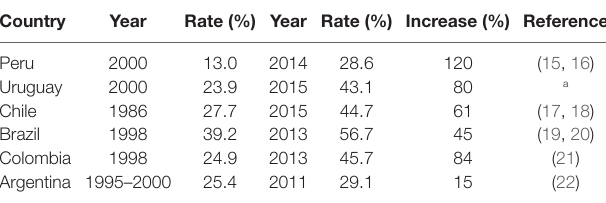
TAbLe 1 | Changes in C-section rates in Latin American